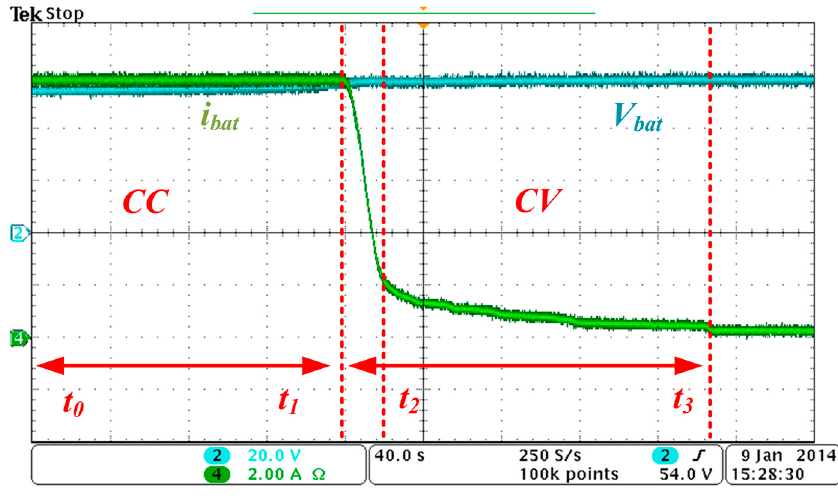
Figure 10. The CC/CV waveform.